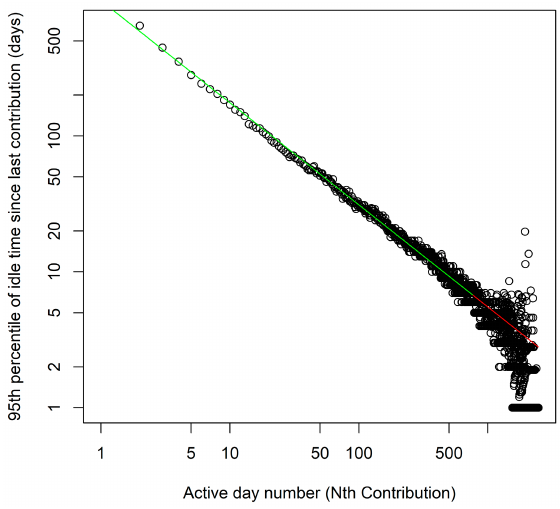
Figure 1. The 95th percentile of delays (days) between a Nth contribution and the previous one. An exponential model of the distribution covering 99.9% of contributors (i.e., a subset) is drawn on the log-log graph (green line). The model was extrapolated for the remaining 0.1% of contributors (red line) where delays were diverging.